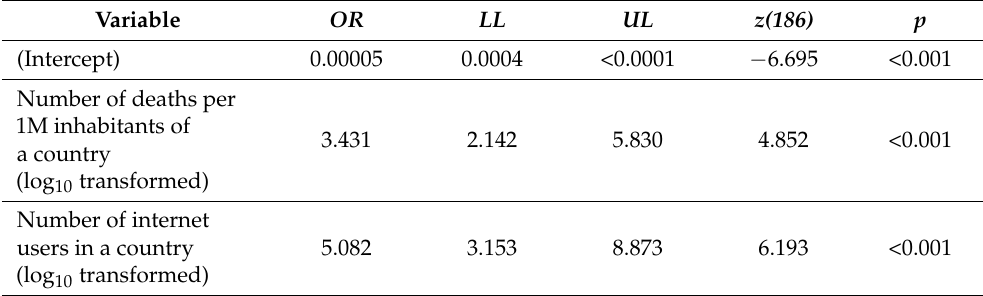
Table 3. Results of the GLM testing the association between the occurrence of interest in coronavirus memes (Google Trends index) and total number of deaths due to COVID-19 per one million inhabi- tants and percentage of internet users in different countries. Odds ratio (OR) with 95% confidence intervals (LL–lower confidence intervals, UL–upper confidence intervals) and Wald z–test (with residual degree of freedom). Model explained 33% variation in data (McFadden pseudo- R 2 ). OR